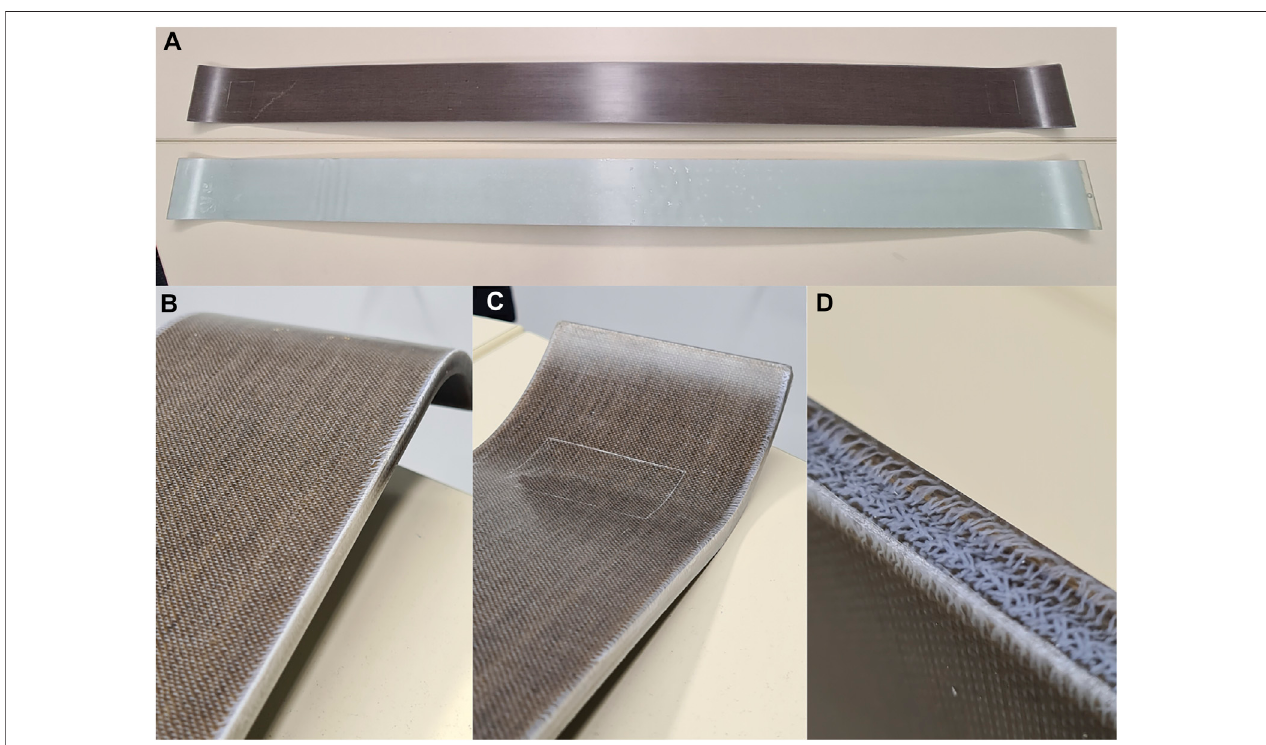
FIGURE 11 | The lower axle tie of the bogie of a narrow-gauge railway, manufactured using the RTM process. (A) Flax/epoxy axle tie (top) compared with the conventional glass fi ber – reinforced axle tie (bottom), (B,C) detailed views of the curved ends of the axle tie, (D) detailed view on the side of the axle tie (component thickness: 70 mm, length approx. 1.2